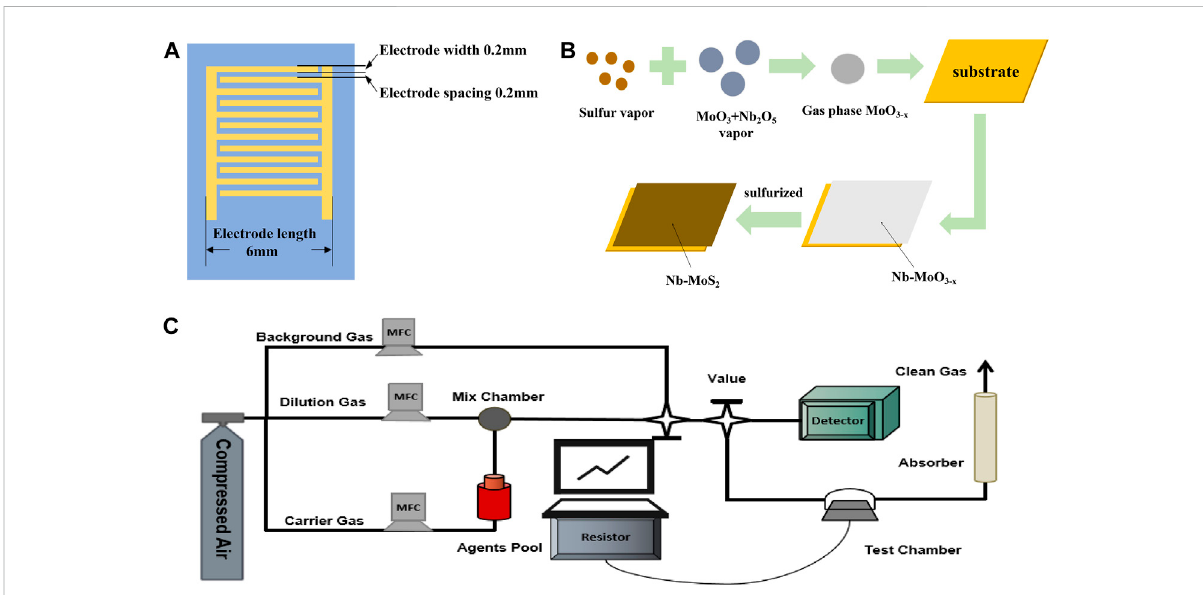
FIGURE 1 (A) The geometry of the electrodes of the sensor; (B) The process of fabricating electrodes and gas sensors, (C) A homemade dynamic gas detection system